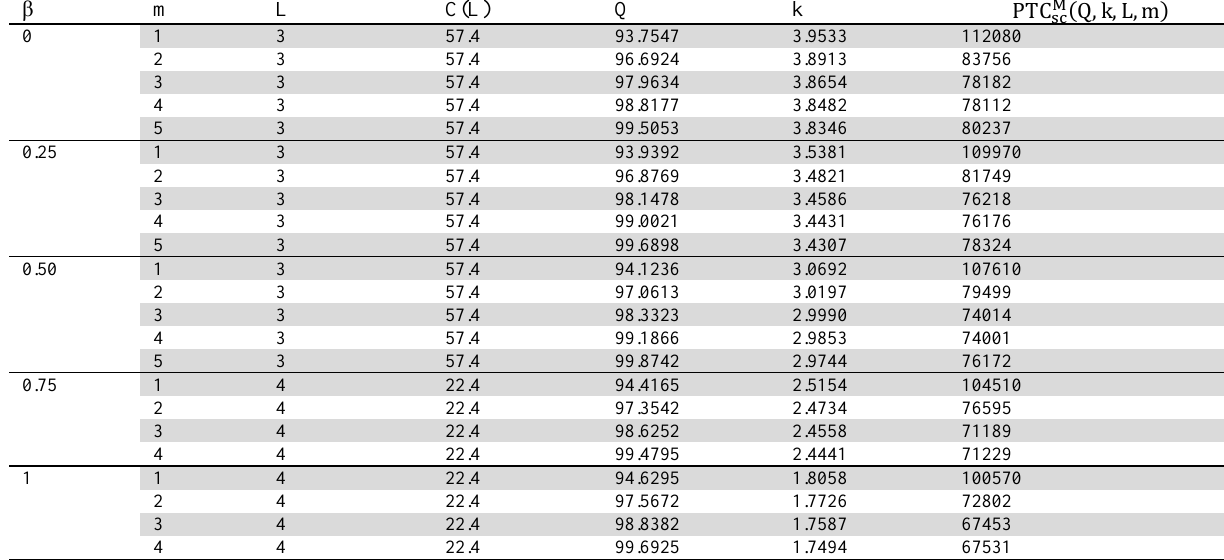
Solution procedures for numerical example 2